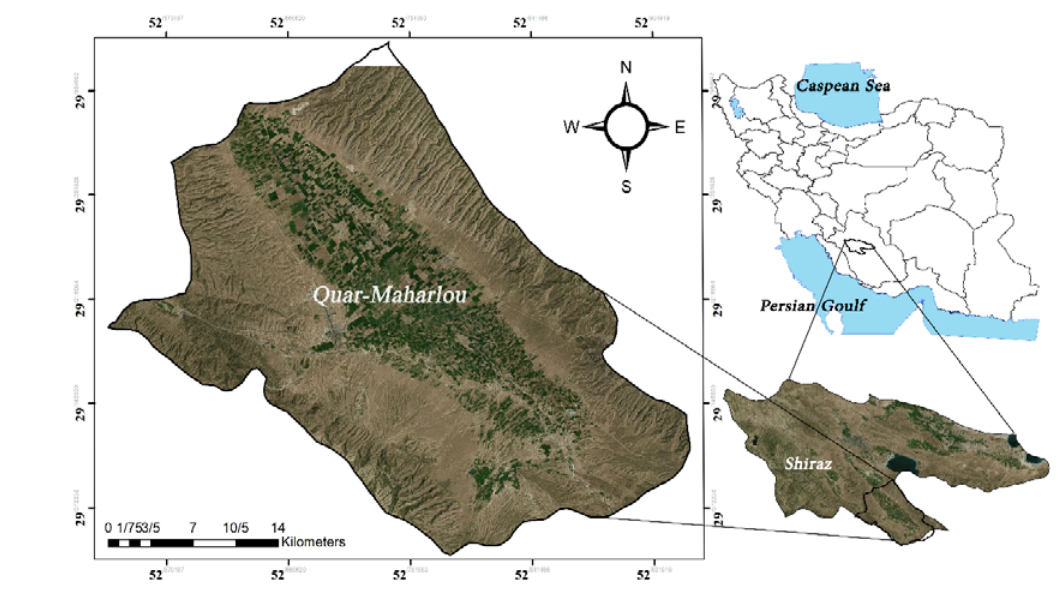
Figure 1. The geographical location of Quar-Maharlou